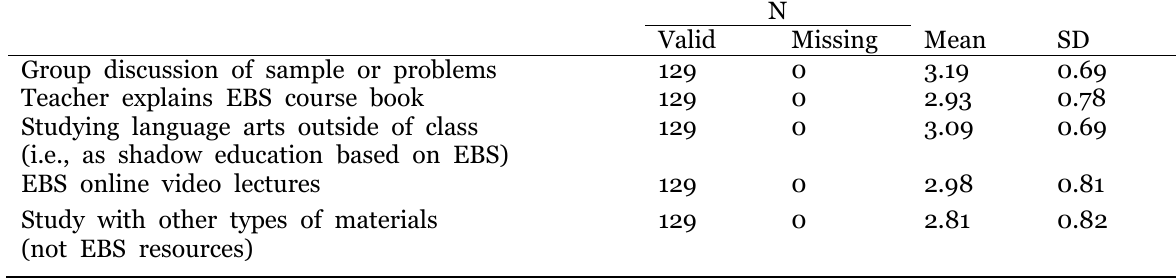
Means and Standard Deviations of Students’ Perceived Helpfulness of Ways of Learning Language Arts Subject (1 = very unhelpful, 4 = very